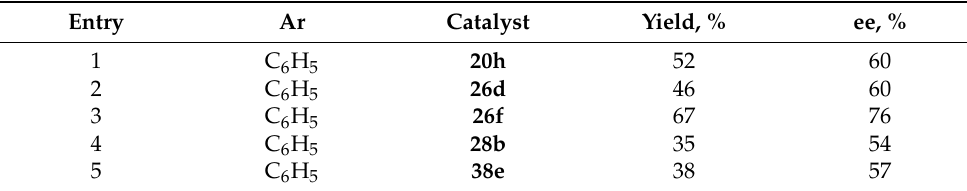
Table 8. Effect of crown ethers in the MIRC reaction of arylidene-1,3-diphenylpropane-1,3-diones ( 67 ) and diethyl bromomalonate ( 63 ).